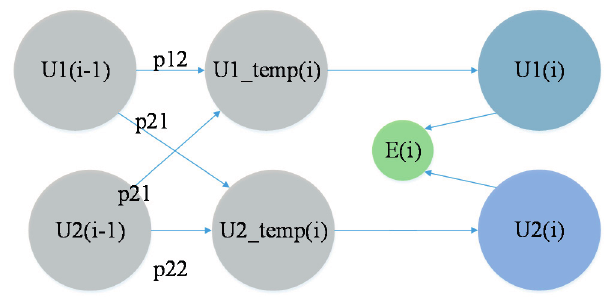
Figure 10. Flow diagram of the IMM